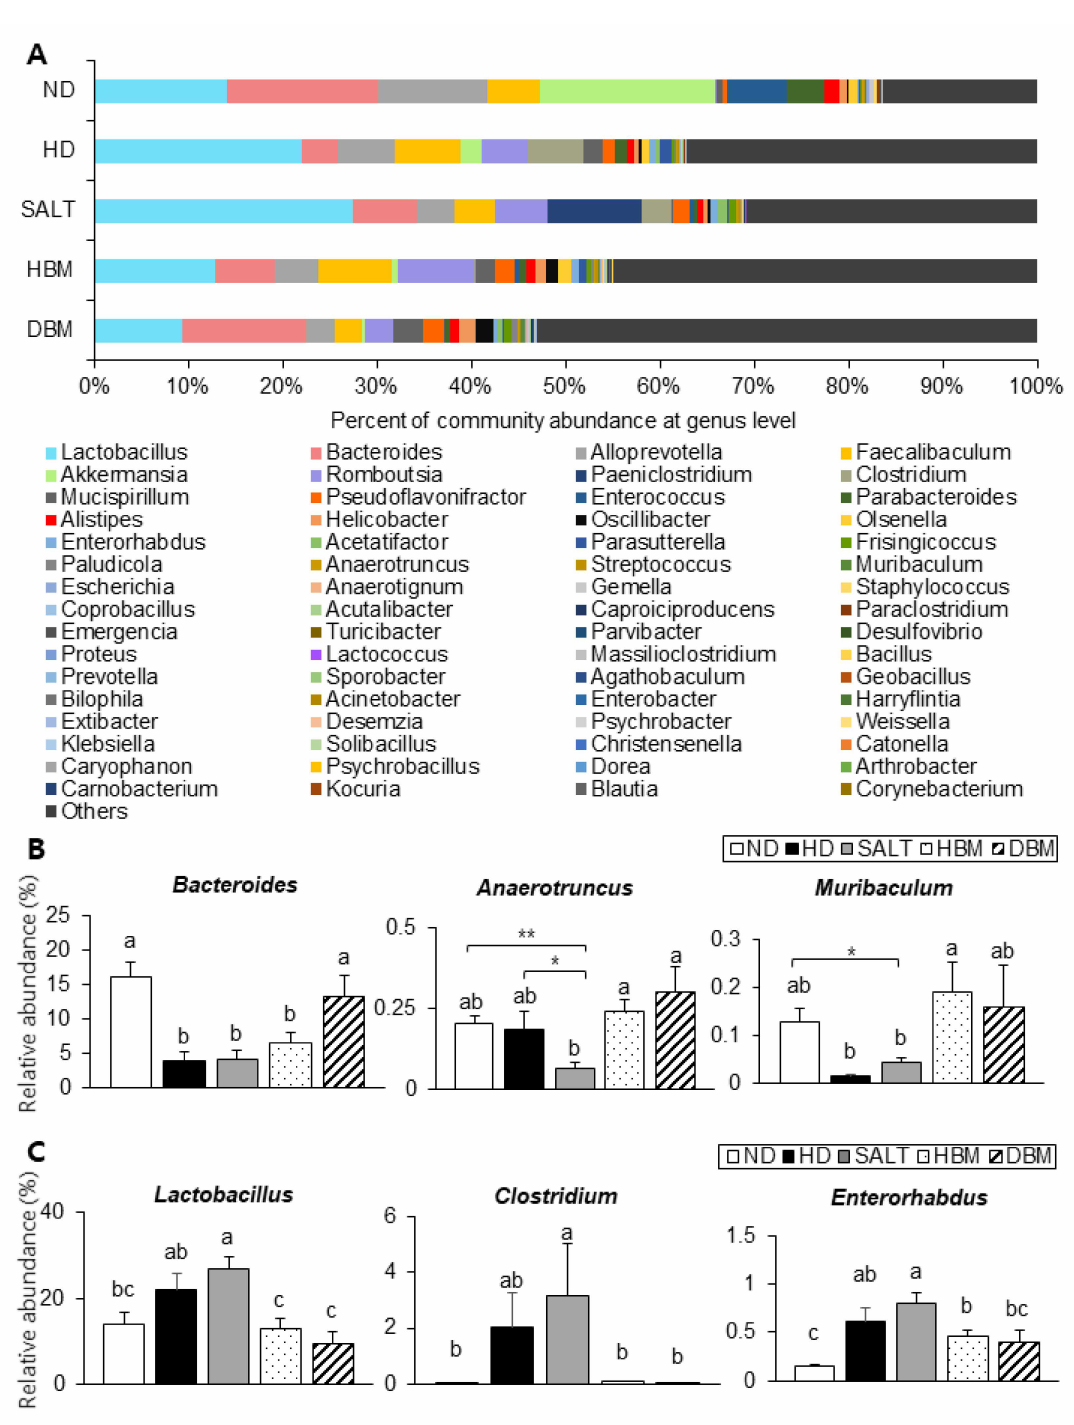
Figure 8. Effect of Gochujang on the population structure of gut microbiota at genus level in the HD-fed mice. ( A ) Microbial community at the genus level in mice; The relative abundance of ( B ) Bacteroides , Muribaculum , Anaerotruncus ; ( C ) Lactobacillus , Enterorhabdus , and Clostridium at genus level. Values are mean ± SEM. a–c means with the different letters on the bar ( p < 0.05). (a > b > c). * p < 0.05 and ** p < 0.01. ND, normal diet group; HD, high-fat diet group; SALT, HD with 0.7% salt group; HBM, HD with 10% of HBM Gochujang group; DBM, HD with 10% of DBM Gochujang